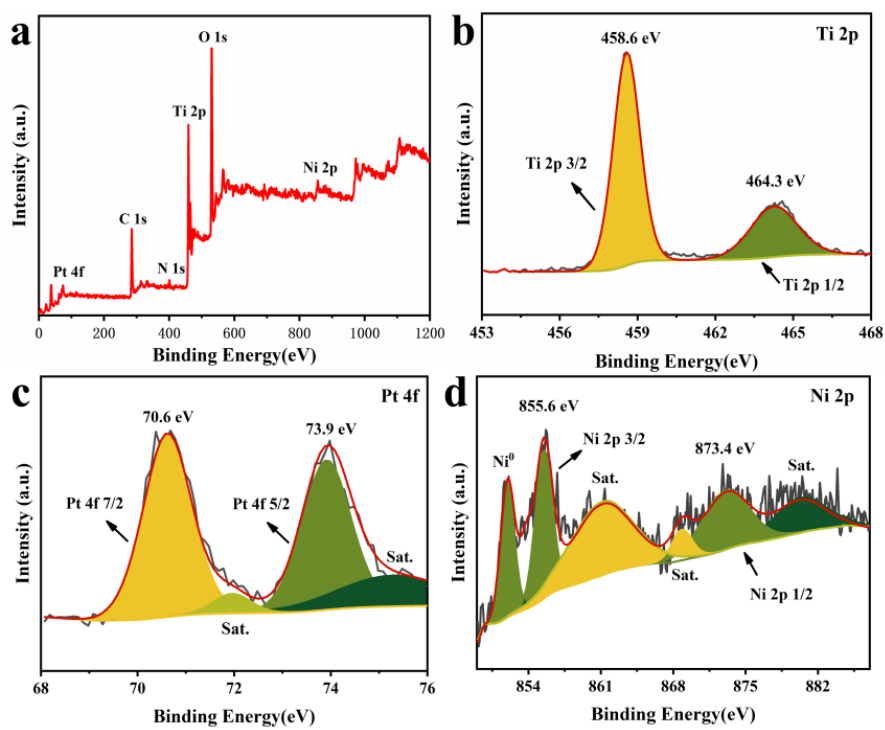
Figure 5. X-ray photoelectron spectra of Pt-Ni/PTOC catalyst ( a ) full spectrum; ( b ) Ti 2p; ( c ) Pt 4f; ( d ) Ni 2p.